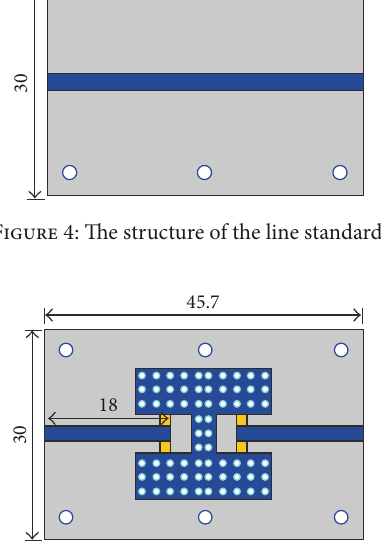
Figure 5: The structure of the match standard.